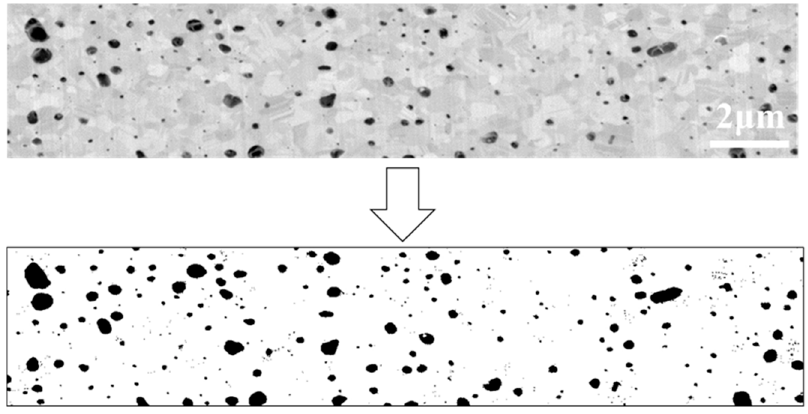
Figure 3. Cross-section scanning electron microscope (SEM) and the filtering images of s-Ag (upper side: cross section SEM image, bottom side: binary image after filtering the SEM image).